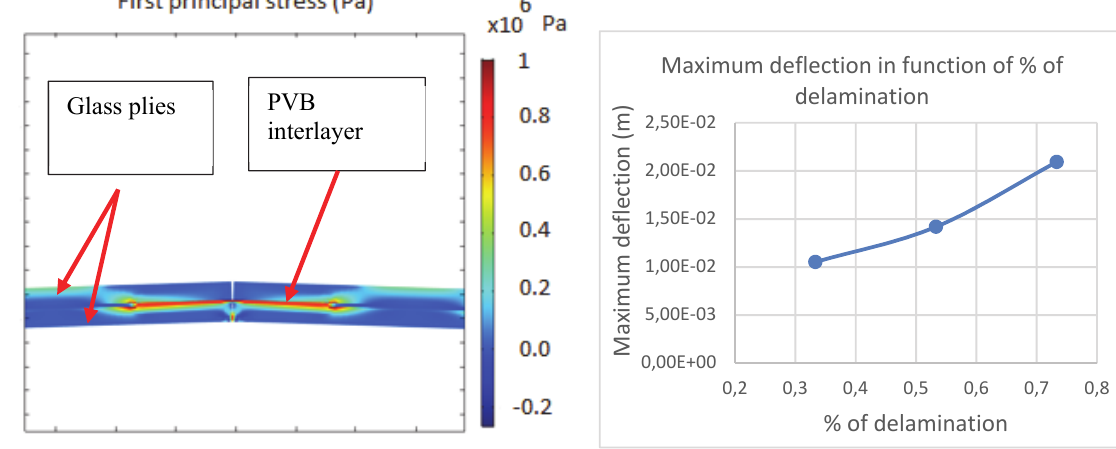
Fig. 3: a) distribution of first principal stress at the junction between two shards for 55% delamination b) maximum deflection of a pane in function of the percentage of PVB